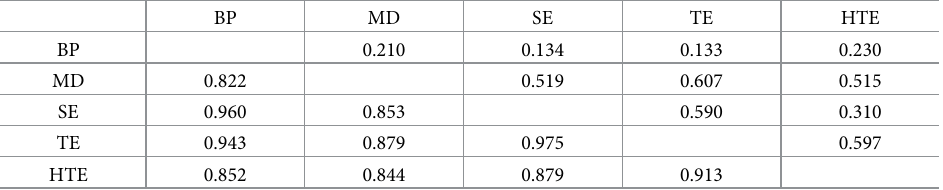
Pearson correlation between various secondary structure metrics, as computed in [6]: base pair distance (BP), string edit distance (SE) [1], mountain distance (MD) [2], tree edit distance (TE) [3] and coarse tree edit distance (HTE) [4]. Lower triangular values indicate intra-ensemble correlations; upper triangular values indicate inter-ensemble correlations. Table values are taken from